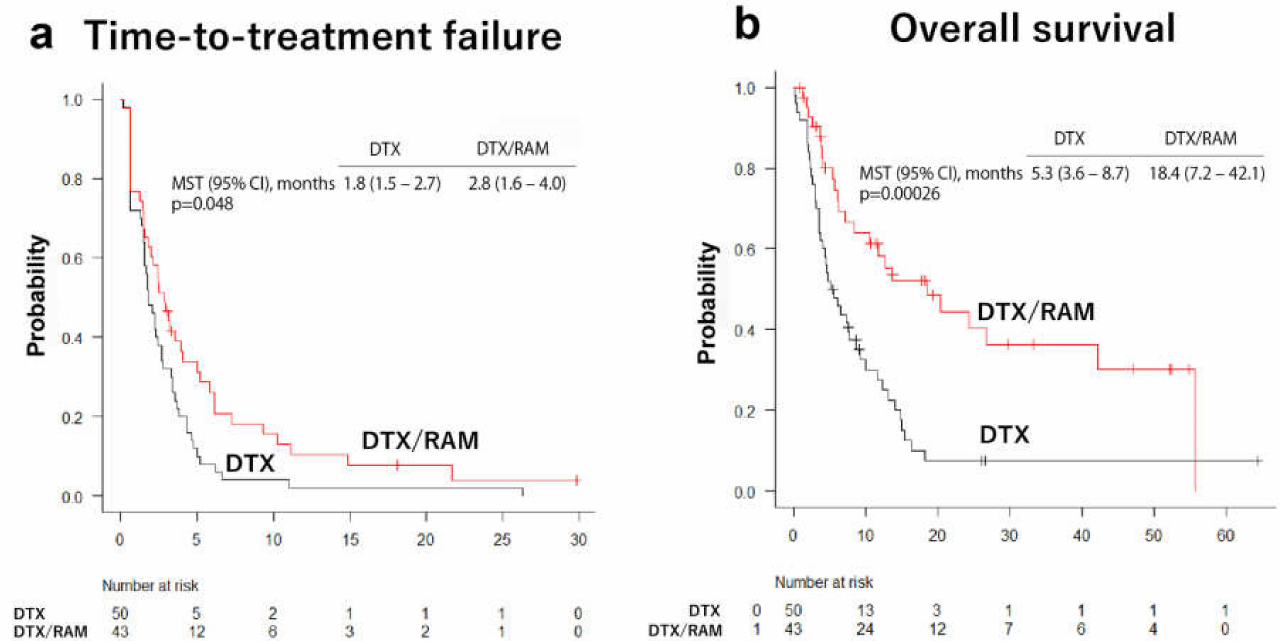
Figure 2. The time-to-treatment failure and overall survival in all patients. The overall survival was significantly improved by the combined treatment with docetaxel and ramucirumab (DTX/RAM) compared to docetaxel (DTX) therapy alone. No difference was observed in time-to-treatment failure between both treatment groups. MST, median survival